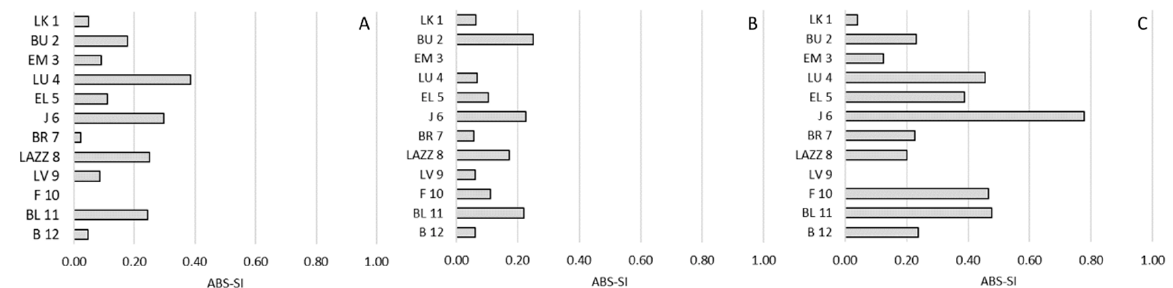
Figure 5. Strength of the bias of side preference (ABS-SI) and social hierarchy in Barbary macaques . Individuals (y-axis) are presented according to their social rank from 1 (the most dominant macaque) to 12 (the most dominated macaque), based on the CBI. ( A ): approach; ( B ): proximity; ( C ): affiliative contacts.